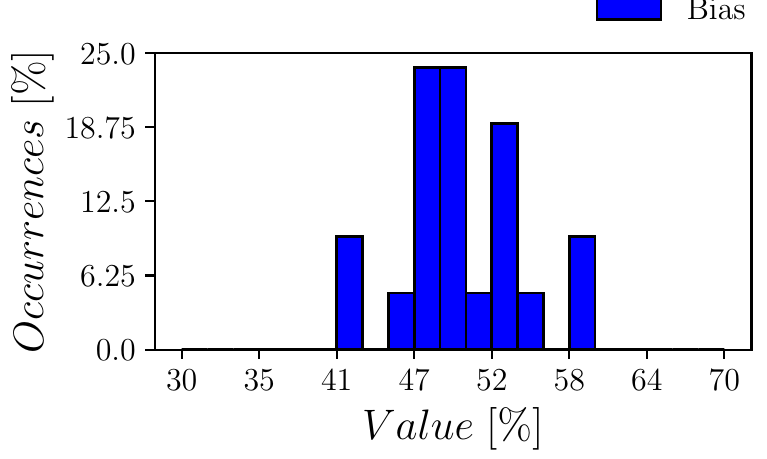
Figure 4. Histogram of the Bias for the 128-bits PUF key over the 21 chip samples.